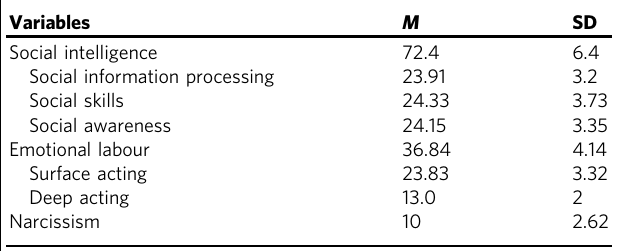
Table 2 Descriptive statistics of scale